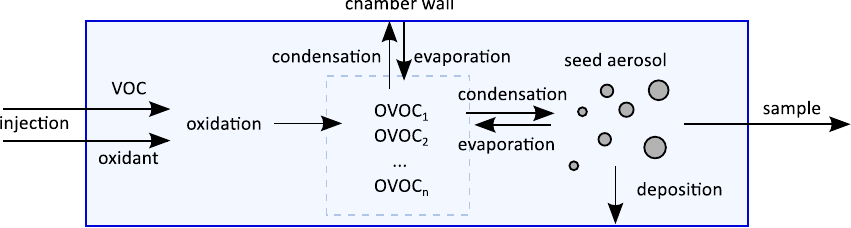
Fig. 1. Schematic of processes modifying the concentrations of particle and gas phase organics during an oxidation chamber experiment